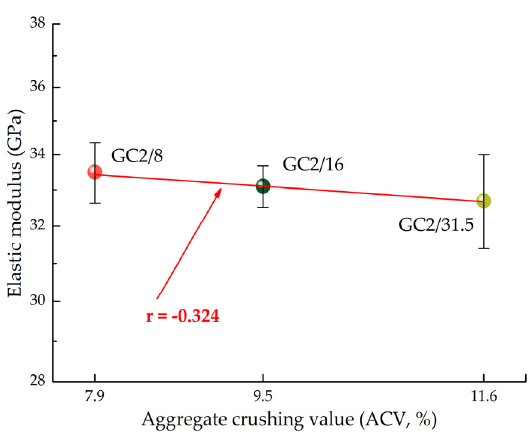
Figure 5. Correlation between aggregate crushing value and elastic modulus E of concrete.